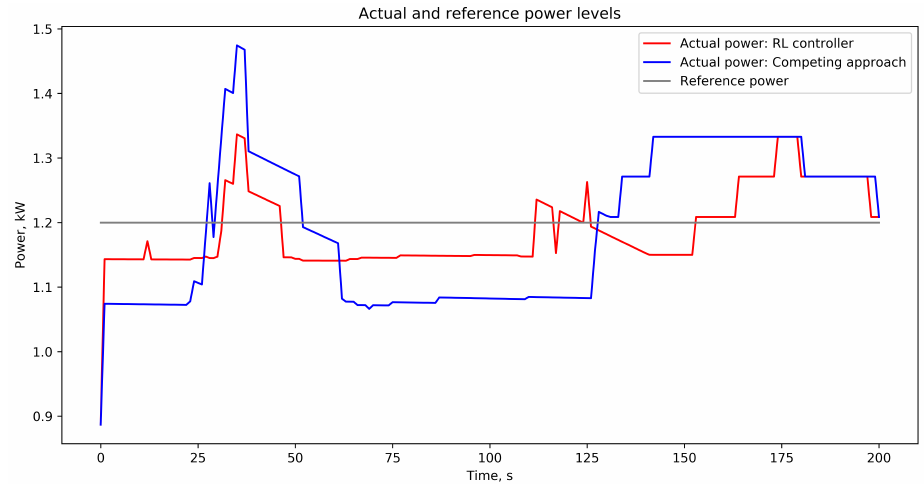
Figure 10. Actual and reference power level example for a trained controller and the compet- ing